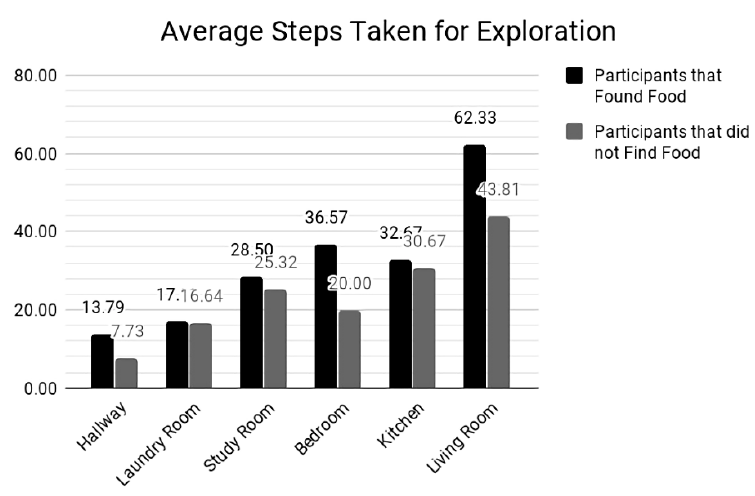
Figure 7. Average number of steps taken during exploration mode.